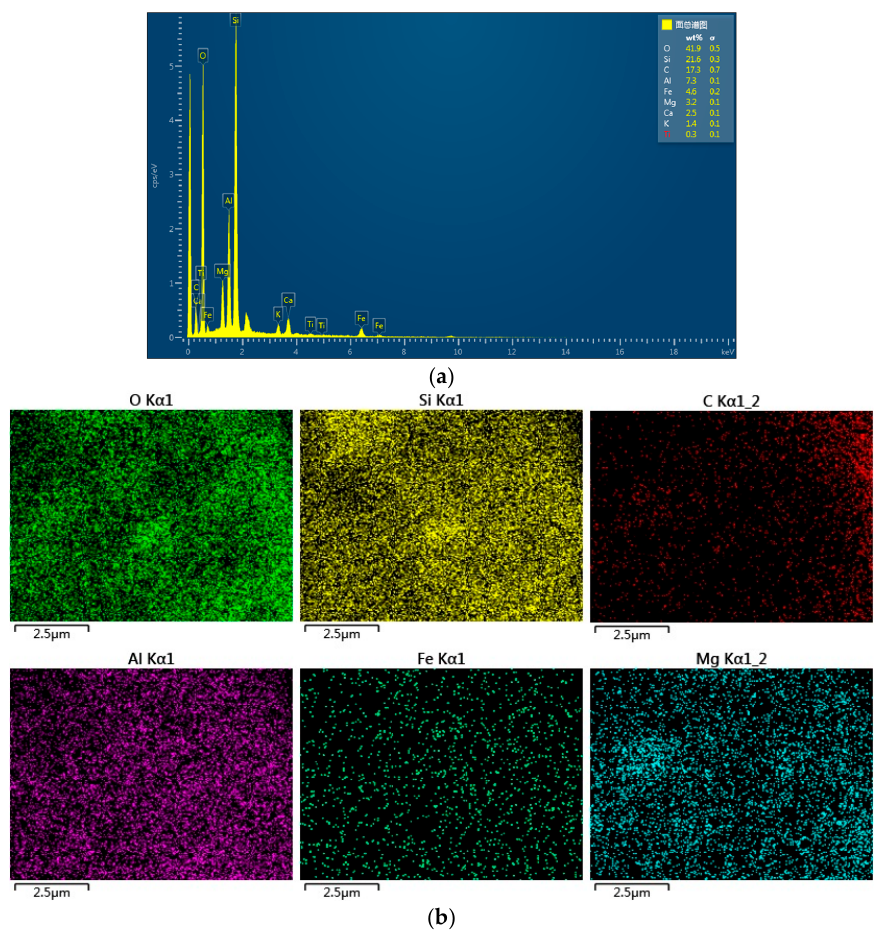
Figure 3. Energy dispersive spectra (EDS) of the pristine palygorskite powders ( a ); and EDS element mappings of the O, Si, C, Al, Fe and Mg elements ( b ).